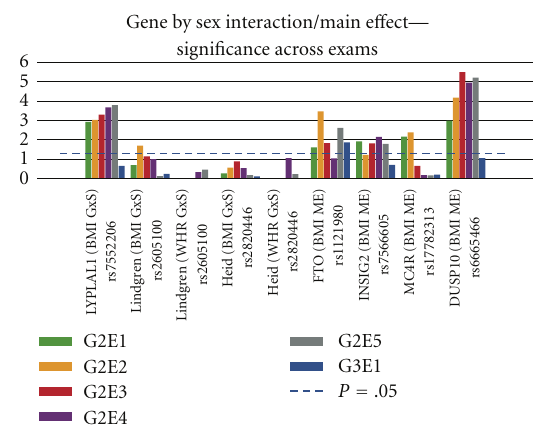
Figure 4: Significance level of main e ff ect (ME) and/or gene by sex interaction (GxS) associations with body mass index (BMI) and/or waist to hip ratio (WHR) for various loci of